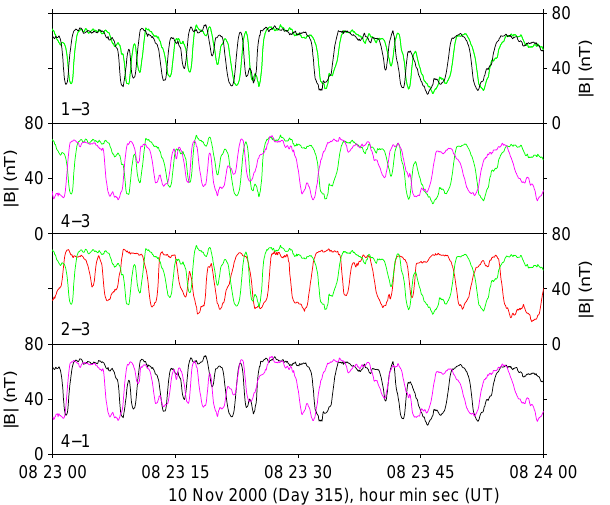
Fig. 6. The same data as in Fig. 5, but one data set is shifted by the time of the peak cross-correlation coefficient. Cluster 3 is used as the reference in the top three panels, and Cluster 1 is used as the reference in the bottom